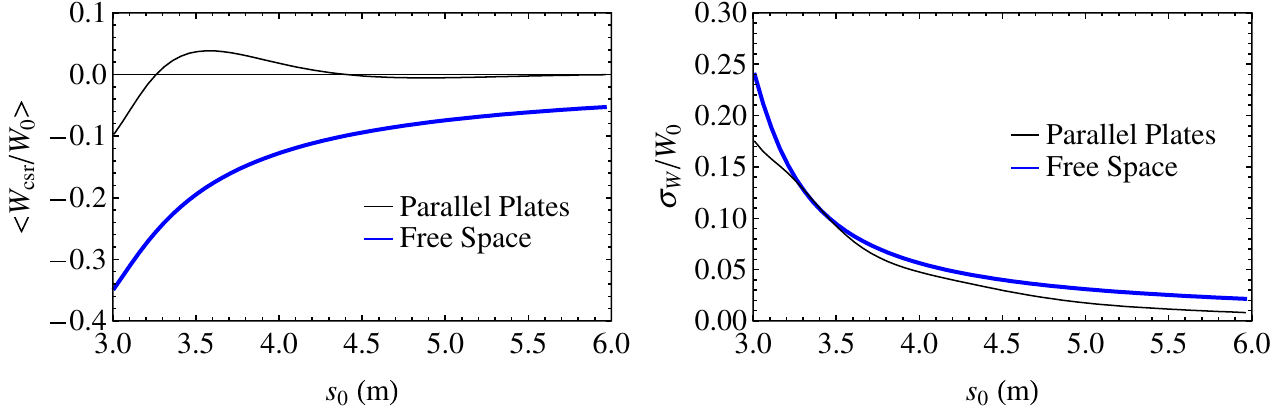
FIG. 14. (Color) The average energy loss and energy spread per unit length of the exit wakes in Fig. 13. In this example, shielding by parallel plates drastically reduces the energy loss, but only marginally reduces the energy spread, when compared to free space calculations.